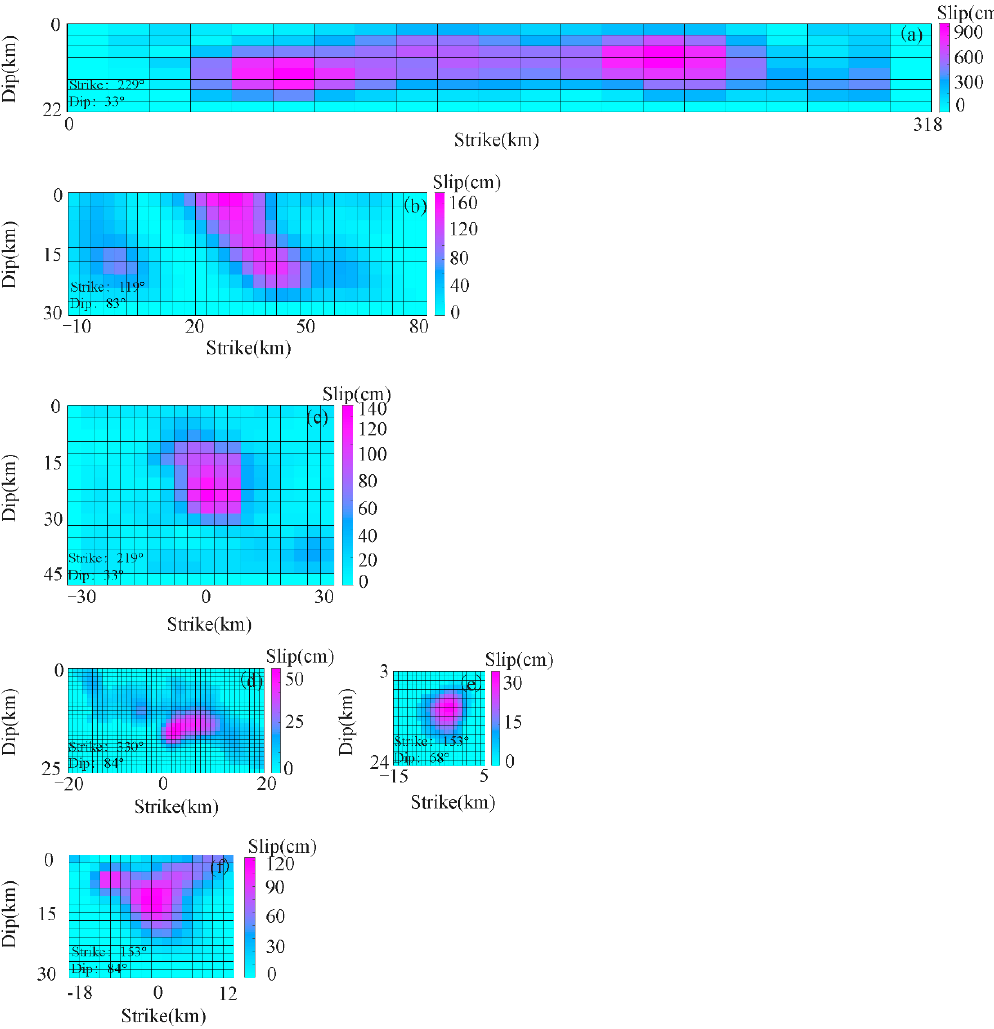
Figure 2. Slip distributions for the source models of ( a ) the 2008 Ms 8.0 great Sichuan (Wenchuan) earthquake (http://www.geol.ucsb.edu/faculty/ji/big_earthquakes/2008/05/12/ShiChuan.html, accessed on 1 January 2016), ( b ) the 2010 Ms 7.1 Yushu earthquake [21], ( c ) the 2013 Ms 7.0 Lushan earthquake [67], ( d ) the 2014 Ms 6.3 Kangding earthquake [19], ( e ) the 2014 Ms 5.8 Kangding earthquake [19], and ( f ) the 2017 Ms 7.0 Jiuzhaigou earthquake [68].